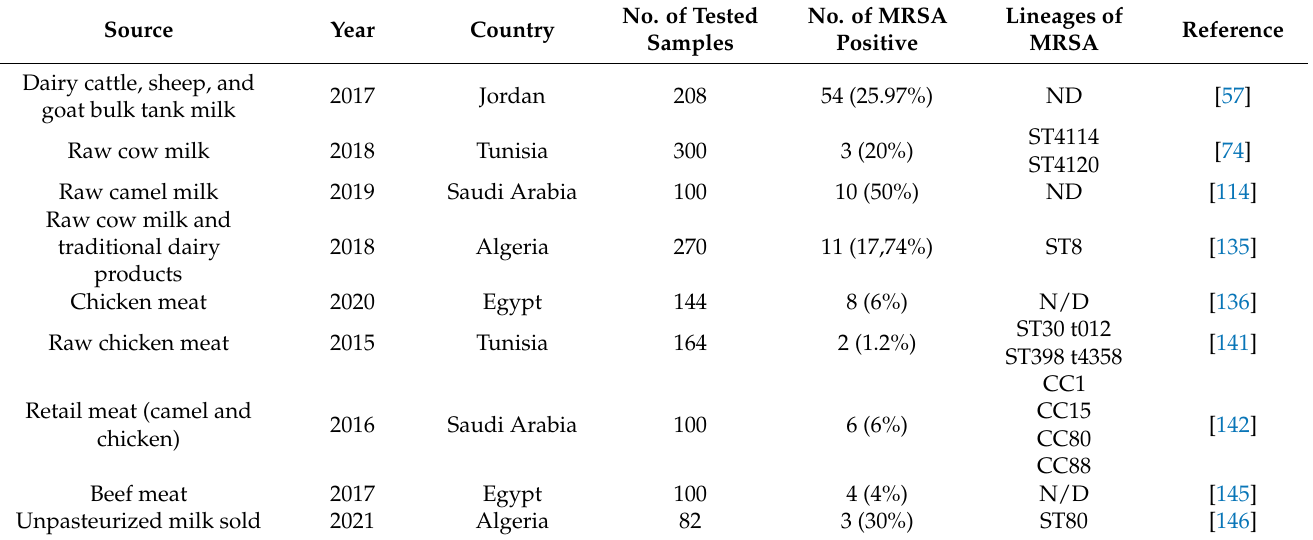
Table 3. Prevalence and types of MRSA in food products in Arab